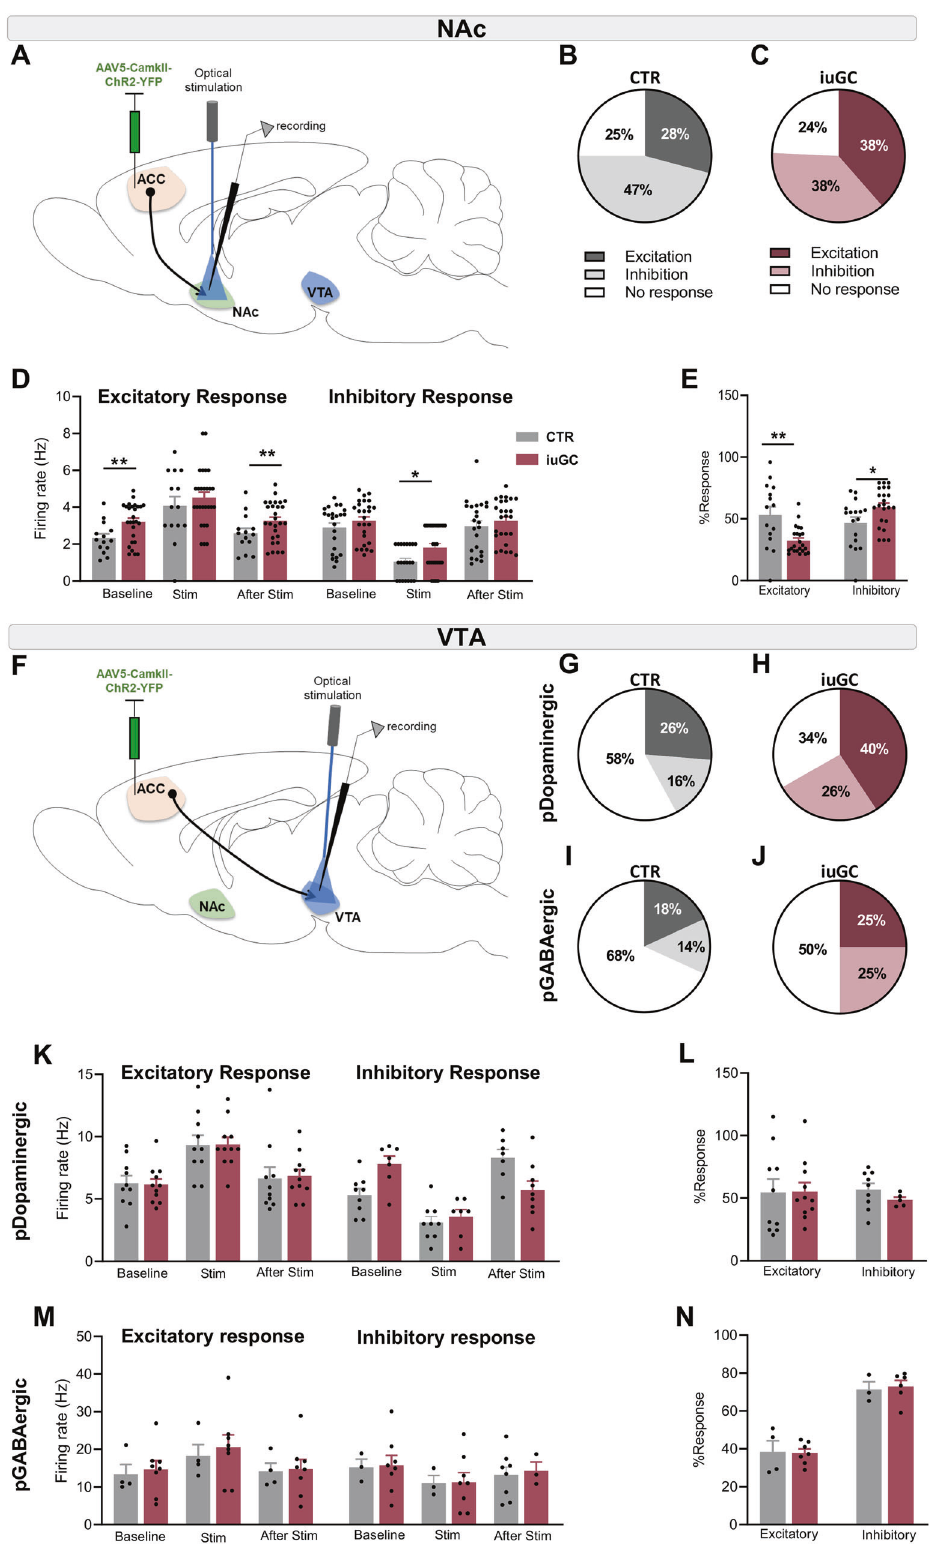
respond to stimulus similarly to CTR rats (Fig. 4M, N and Supplementary Fig. 5C, F). Overall, these data suggest that iuGC exposure changes ACC and NAc neuronal activity, and signi fi cantly impairs